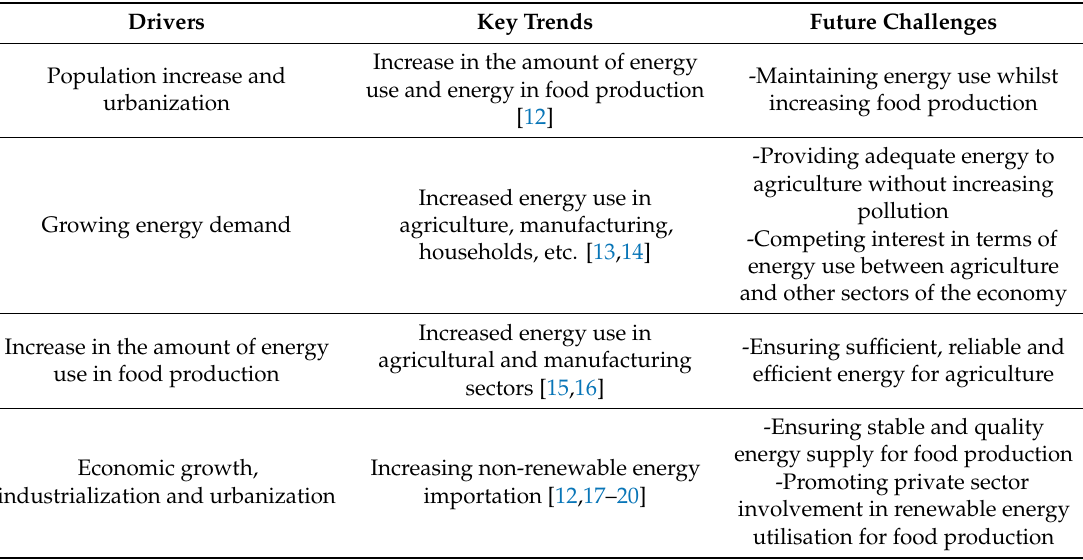
Table 1. Drivers, trends and challenges to energy use in South